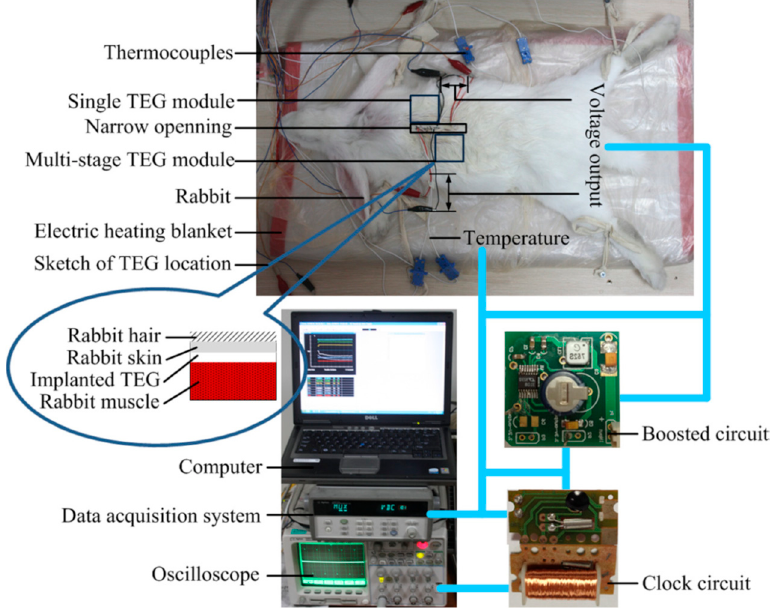
Figure 16. In vivo experimental setup with a rabbit [94].